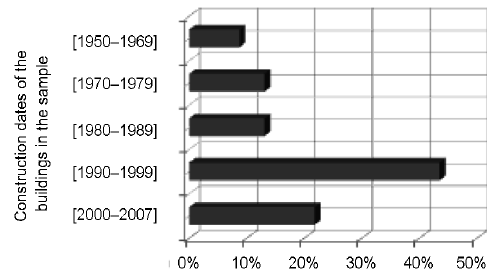
Fig. 1. Construction dates of the buildings in the sample